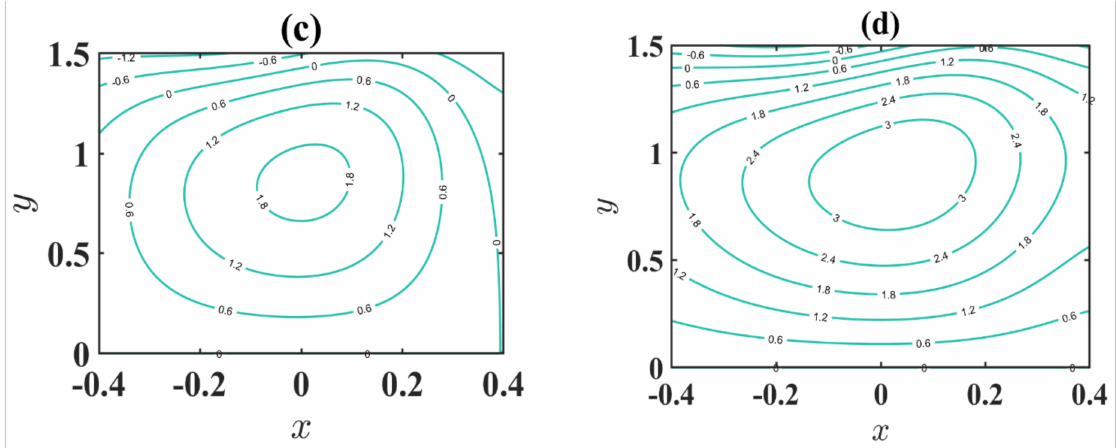
Figure 7. Streamlines for ( a ) U hs = − 1, ( b ) U hs = 0, ( c ) U hs = 1 and ( d ) U hs = 2.